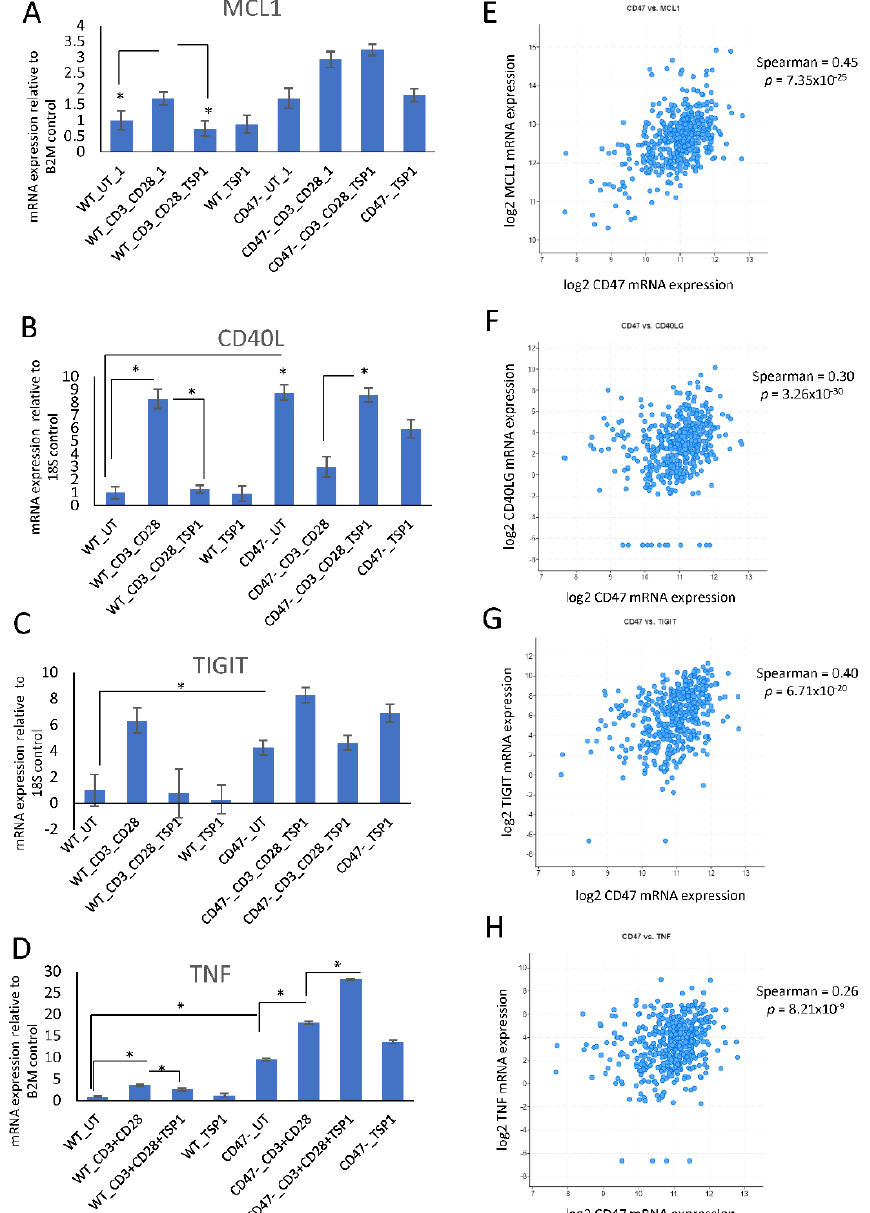
Figure 6. CD47 dependence of immune checkpoint and MCL1mRNA expression in vitro and in melanomas. ( A–C ) WT and CD47 − Jurkat T cells were activated on wells coated with anti-CD3 plus anti-CD28 in the presence or absence of 1 µ g/mL TSP1 for 6 h. Total RNA was extracted using the Trizol method, and mRNA expression of MCL1 ( A ), CD40L ( B ), TIGIT ( C ), and TNF ( D ) was determined via real-time PCR normalized to 18S or B2M controls, as indicated. Error bars indicate technical replicates for MCL1, CD40, and TIGIT (* = p -values ≤ 0.05, n = 3). ( E – H ) Coexpression of CD47 mRNA with MCL1 ( E ), CD40LG ( F ), TIGIT ( G ), and TNF ( H ) mRNAs was analyzed for 472 TCGA cutaneous melanoma